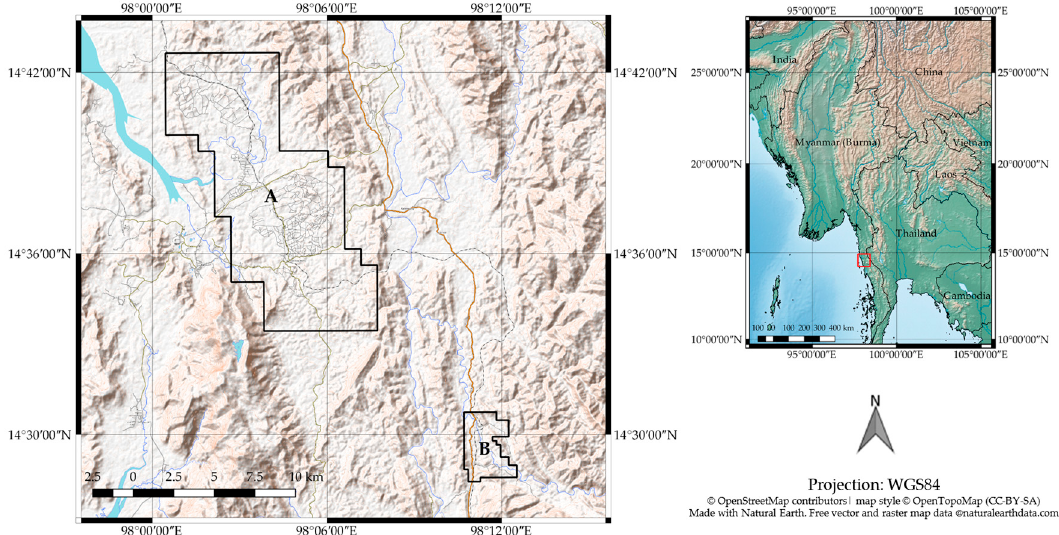
Figure 3. Study sites (A and B) covering oil palm plantations in Dawei district, Tanintharyi, Myanmar. The maps were created with OpenStreetMap contributors ( left ) and Natural Earth ( right ).